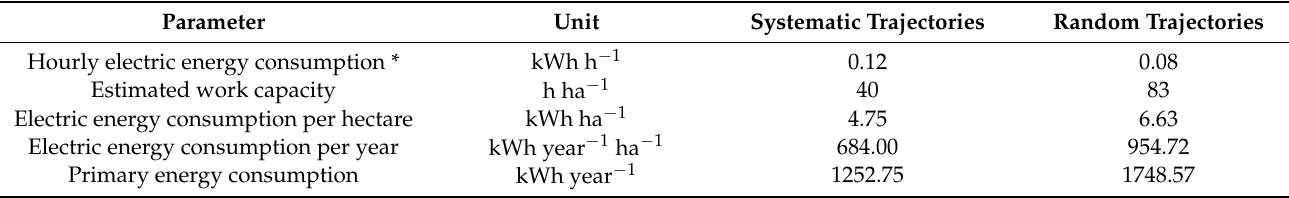
Table 5. Operating characteristics and energy consumption estimation according to different autonomous mowers’ mowing patterns in the two